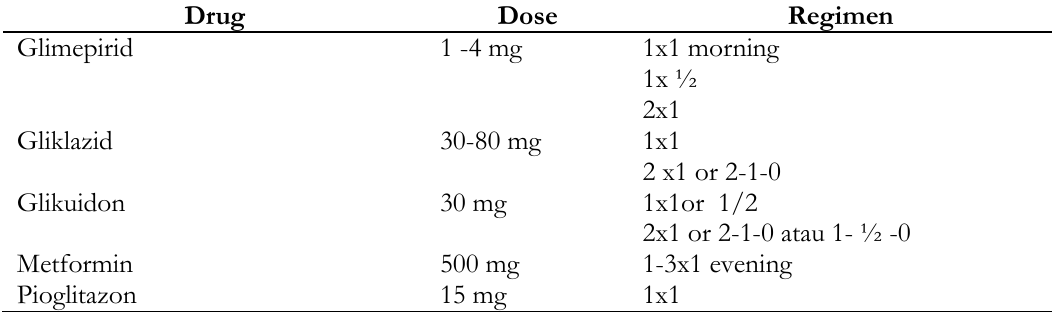
Table III. Dose and regimen of oral antidiabetes in geriatric outpatients Dr. Soetomo Hospital